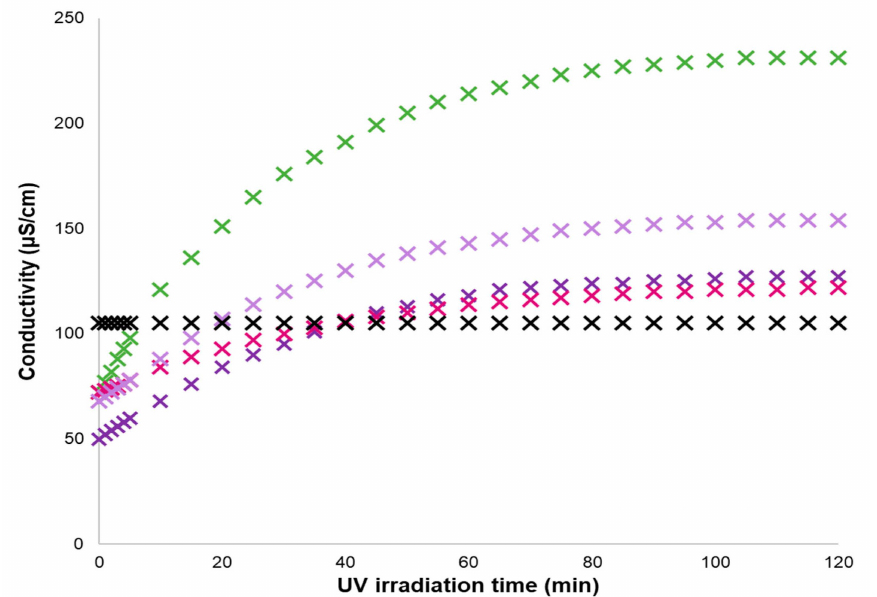
Figure 3. Conductivity data of 6.73 × 10 − 4 mol% IMC1, CH, ET3N, PY and of 1.35 × 10 − 3 mol% KCl aqueous solutions upon UV irradiation time at 25 ◦ C ( X black cross—KCl, X green cross—IMC1, X pink cross—CH, X lavender cross—ET3N, X purple